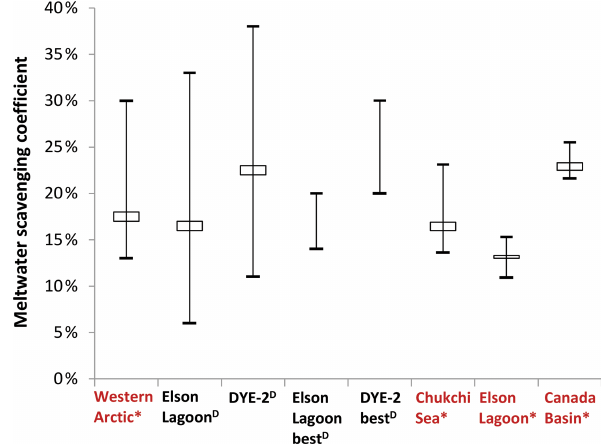
Figure 5. MSC of BC in different regions over the western Arc- tic. Superscript “*” indicates the results of this study (red), and “ D ” indicates the results of Doherty et al. (2013). Elson Lagoon best D and DYE-2 best D indicate the best-estimated range of MSC, respec- tively, in Elson Lagoon and DYE-2, Greenland, published in Do- herty et al. (2013). The values of the western Arctic were estimated based on the observations in all measurement regions, and the best- estimated values in DYE-2 and Elson Lagoon were employed in the estimation. The box shows the mean (upper) and median (bottom) values, and the whiskers depict the